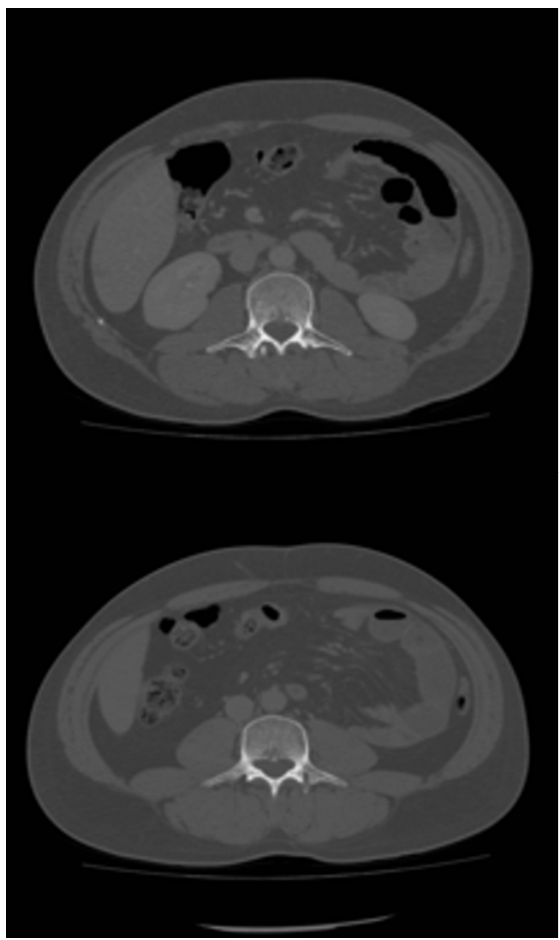
Figure 1. Computer tomography scan, showing fluid filled ileum in the left paraduodenal space with wall